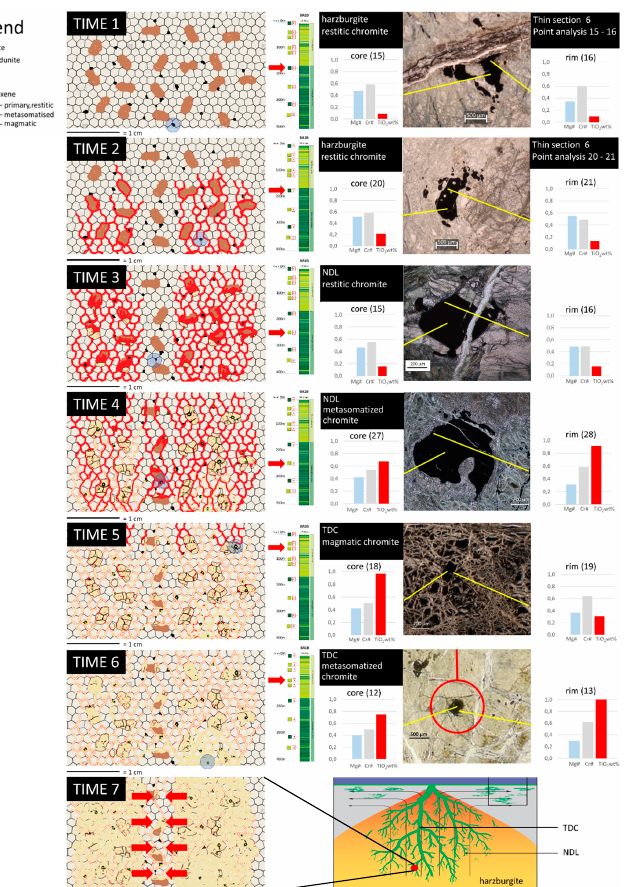
Figure 9. Conceptual model illustrating the chemical signature of the Cr-spinel during the evolution of harzburgite into dunite for studied samples. This evolution envisages the melt percolation through the mantle peridotite developed during seven stages (Time 1 to Time 7). For each Time that leads to the melt / rock interaction we associate optical microscopic images of a Cr-spinel grains, its stratigraphic position (for details see Figure 2) and its EMP analyses with values of Mg#, Cr# and TiO 2 wt. %. Time 1—Harzburgite into the shallow mantle, composed by olivine (light poligons), orthopyroxene (brown) and Cr-spinel (black). Primary Cr-spinel is Ti-poor and there is no chemical zonation. Time 2—A basaltic melt intrudes the harzburgite, percolating along the grain boundaries of olivine, orthopyroxene and Cr-spinel. Cr-spinel grains may come and keep in contact with Ti-rich melt and little variation in TiO 2 content can occur. Time 3—While the basaltic melt intrudes through the harzburgite, orthopyroxene melts and first grains of olivine crystallize. Unreacted Cr-spinel preserves a low content of TiO 2 . Time 4—Orthopyroxenes are dissolved and substituted by magmatic olivine. New olivine runs to equilibrium with restitic olivine very fast. At the same time, very close (less than 2 cm) to the unreacted Cr-spinel grain of Time 3, another Cr-spinel grain is completely plunged into the Ti-rich melt and reacts strongly recording very high contents of TiO2. Time 5—Magmatic olivine has crystallised within orthopyroxene sites and along grain boundaries. During the process of rock / melt reaction, also Ti-rich Cr-spinel cores can be found and interpreted as new Cr-spinel grains. Time 6—The flow of the basaltic melt, now disappeared, is replaced by a network of magmatic olivine that continues to react under subsolidus conditions, inducing metasomatic reactions in the restitic olivine. Time 7—Two dunitic channels, homogeneous in composition, run to merge forming a bigger channel. The red point / position in the fractal pattern dunite [modified after 1] is only an example, because the same process occurs on every area fluxed / impregnated by the melt and at multiple